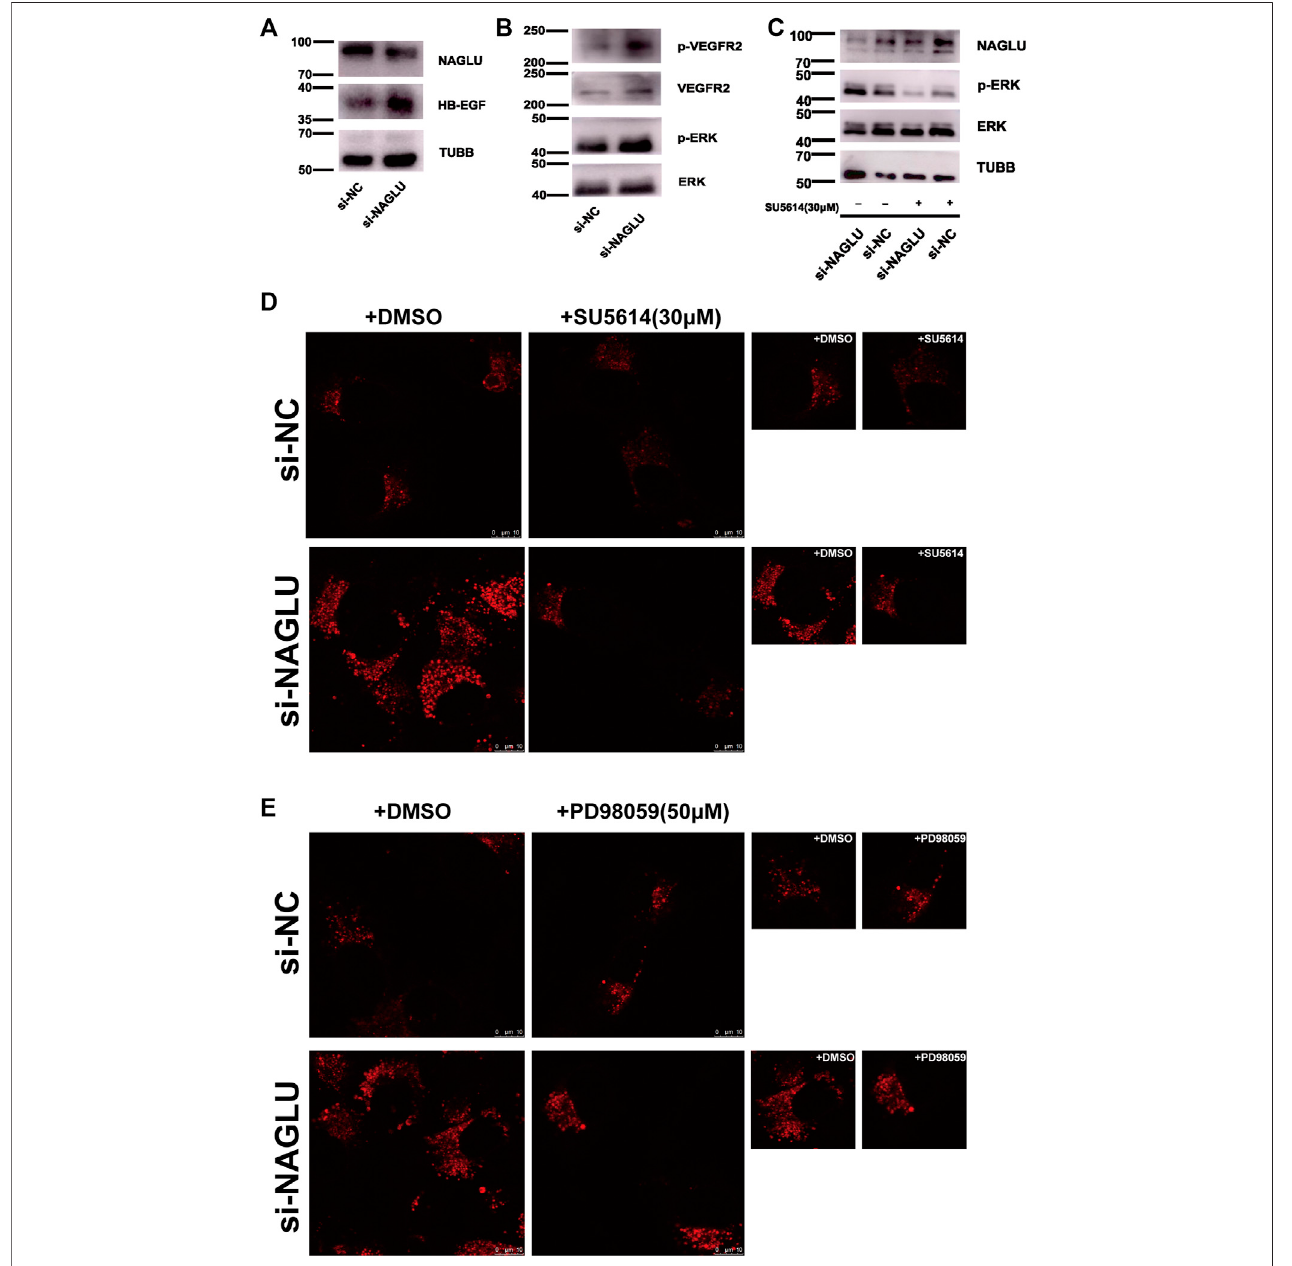
FIGURE 5 | NAGLU knockdown causes aberrantly lysosomal accumulation in HUVEC targeting VEGFR2/ERKs and promotes EAS. (A) The protein expression levels of HB-EGF in HUVEC after transfection with si-NAGLU and si-NC as measured by Western blotting. TUBB was used as a control. (B) VEGFR2 and ERKs phosphorylation levels in HUVEC si-NAGLU and HUVEC si-NC were measured by Western blot. To monitor the equal loading of protein in the gel lanes, the upper blot was stripped and tested using anti-VEGFR2 and anti-ERKs antibodies, respectively. (C) VEGFR2 inhibition reduces ERK1/2 phosphorylation levels in HUVEC si- NAGLU. HUVEC si-NAGLU and HUVEC si-NC were both treated or untreated with 30 μ M VEGFR2 inhibitor SU5614 for 12 h and then measured by Western blot. (D) VEGFR2 inhibition reduces aberrantly lysosomal accumulation in HUVEC si-NAGLU. Representative images of lysosomes labeled by the LysoTracker probe in HUVEC si-NAGLU and HUVEC si-NC, both treated with 30 μ M SU5614 for 12 h. Scale bars: 10 μ m. (E) MAPK/ERKs inhibition reduces aberrant lysosomal accumulation in HUVEC si-NAGLU. Representative images of the lysosomes labeled by the LysoTracker probe in HUVEC si-NAGLU and HUVEC si-NC, both treated or untreated with 50 μ M PD98059 for 24 h. Scale bars: 10 μ m.